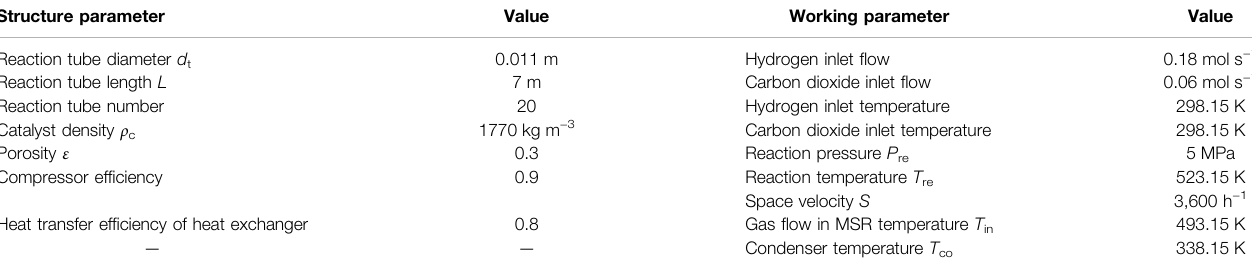
Frontiers in Energy Research |